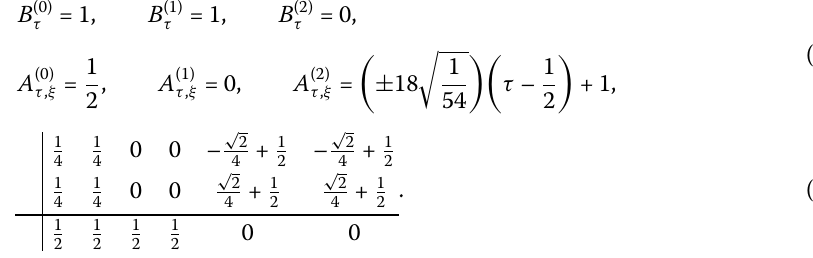
= γ (1) = γ (0) = γ (1) = γ (2) = 0, other choices are also 1 1 2 2 2